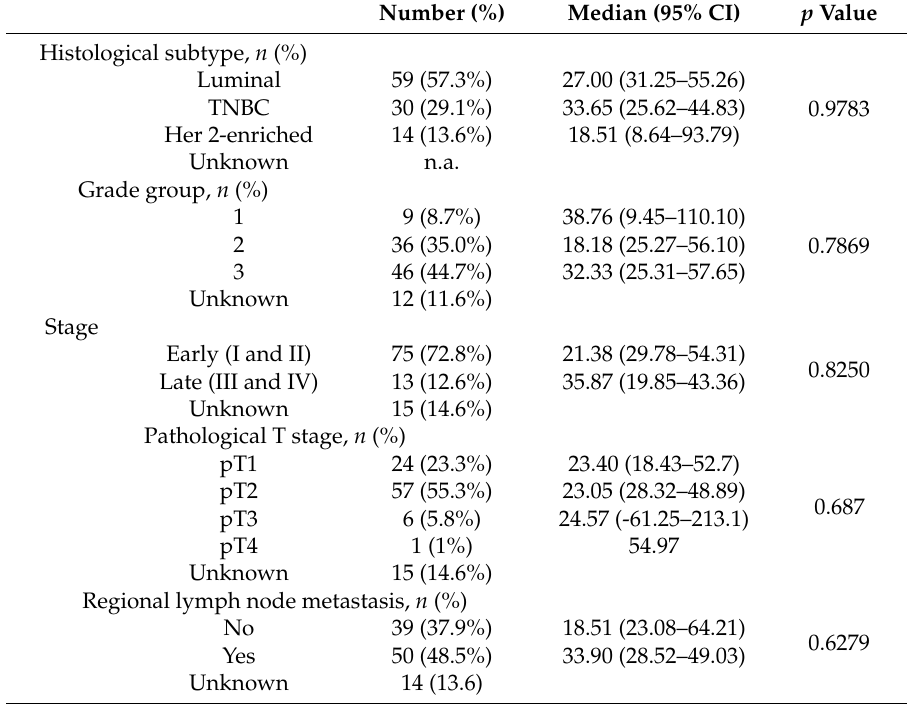
Table 2. Association between tissue miR-99a levels and clinicopathological features of breast cancer patients (cohort